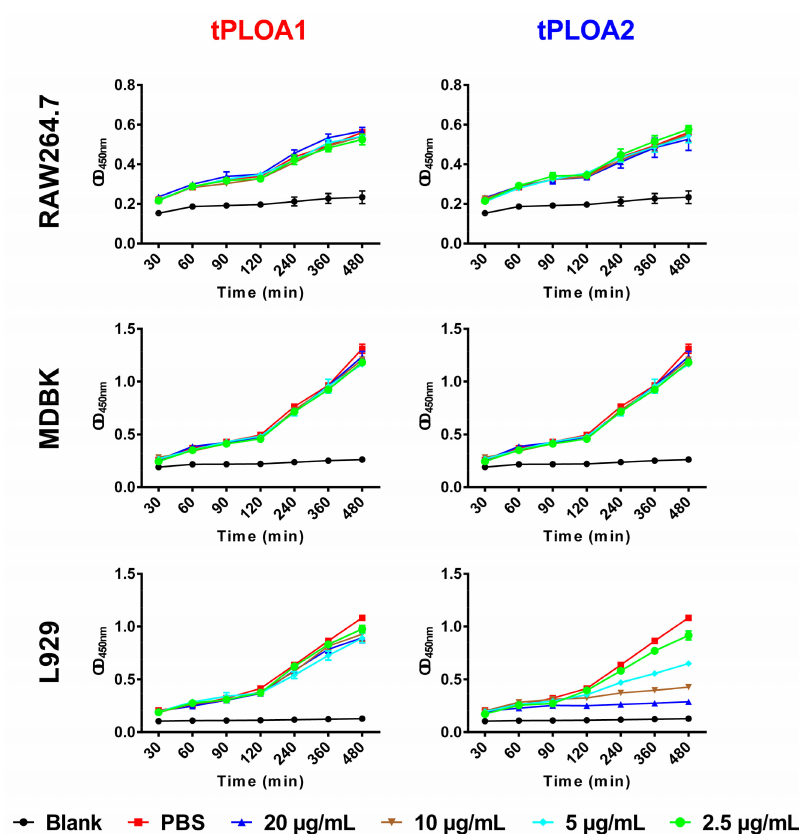
Figure 2. Cytotoxicity of tPLOA1 and tPLOA2 to di ff erent cells. tPLOA1 showed no cytotoxicity to RAW264.7, MDBK, and L929 cells. tPLOA2 showed no cytotoxicity to RAW264.7 cells. In MDBK cells, 20 µ g / mL tPLOA2 showed slight cytotoxicity, while, in L929 cells, tPLO2 showed cytotoxicity at concentrations higher than 5 µ g / mL. The assay was technically repeated for three